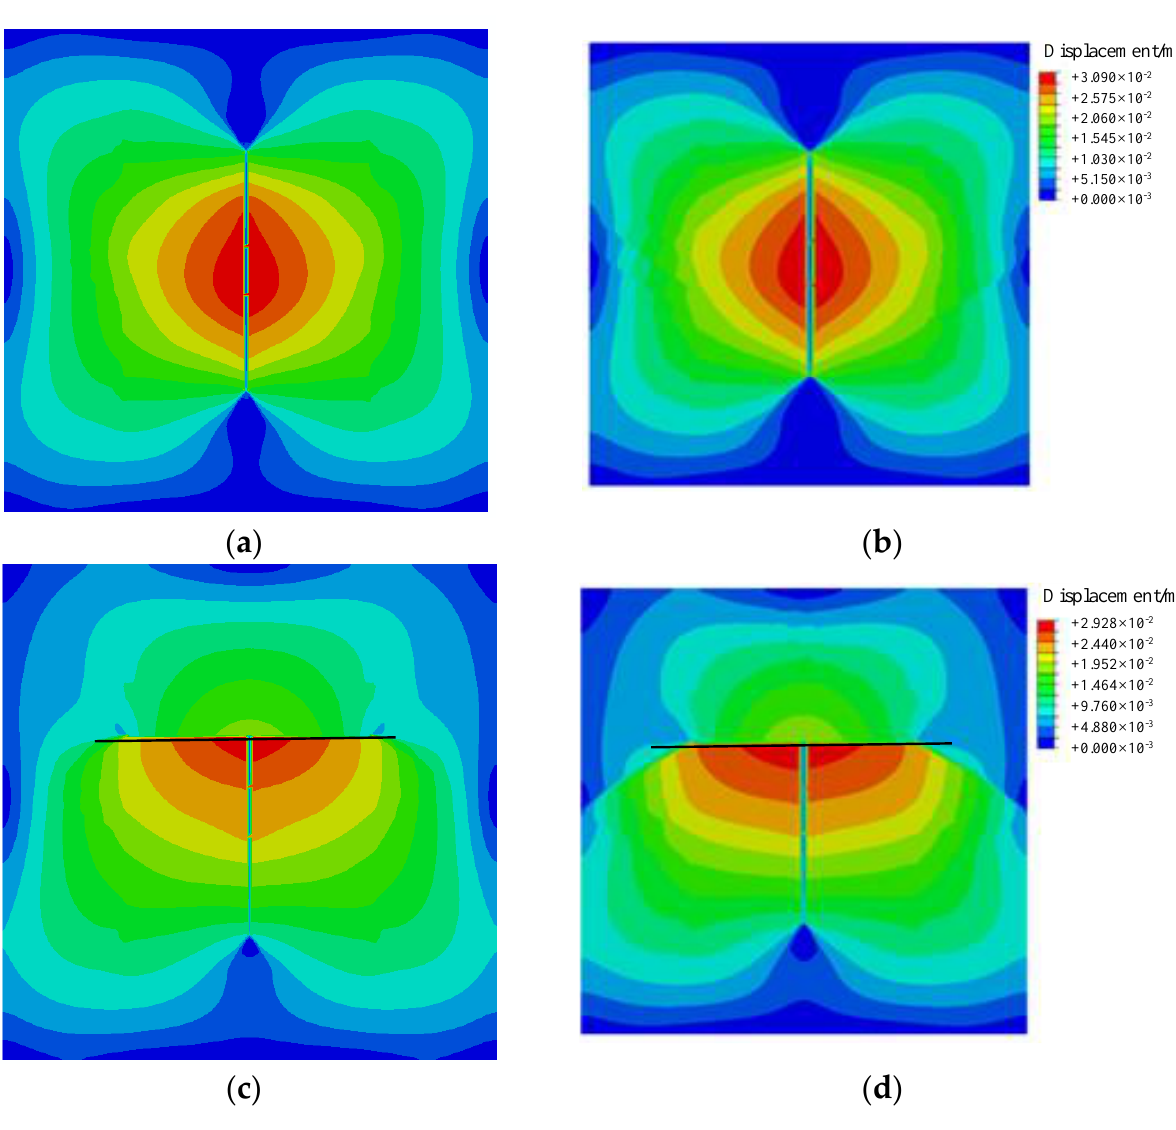
Figure 14. Cloud picture of displacement field under different elastic moduli: ( a ) elastic modulus